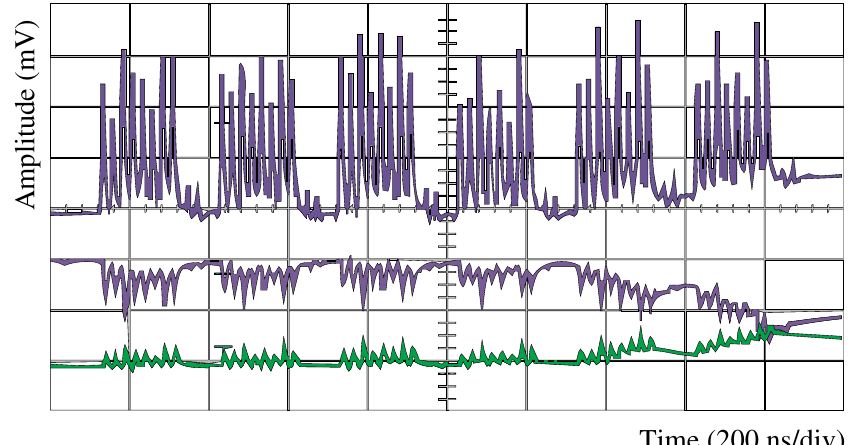
FIG. 6. (Color) Measured baseline drift in a TT2 electrostatic pickup with six gaps of 120 ns. From top to bottom: (cid:21) ( 300 mV = div ), (cid:24) x ( 50 mV = div ), and (cid:24) y ( 50 mV = div